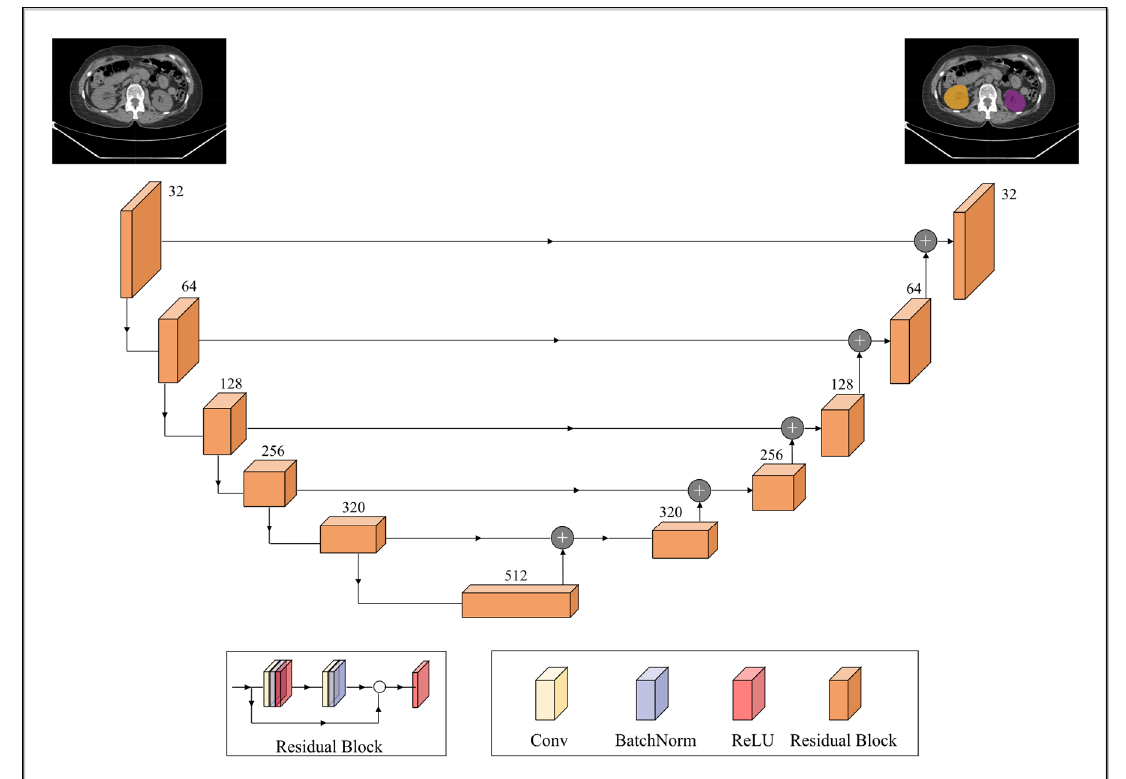
Figure 1. A schematic overview of the employed 2D dilated residual U-net-based segmentation model. The encoder and decoder were composed of 5 cascades of residual blocks. Each residual block was composed of two convolution layers and was cascaded with the downsampling layer (maximum pooling; down arrow) or the upper sampling layer (bilinear interpolation; upper arrow). A shortcut connection (horizontal arrow) was implemented between the corresponding feature maps between the encoder and decoder.